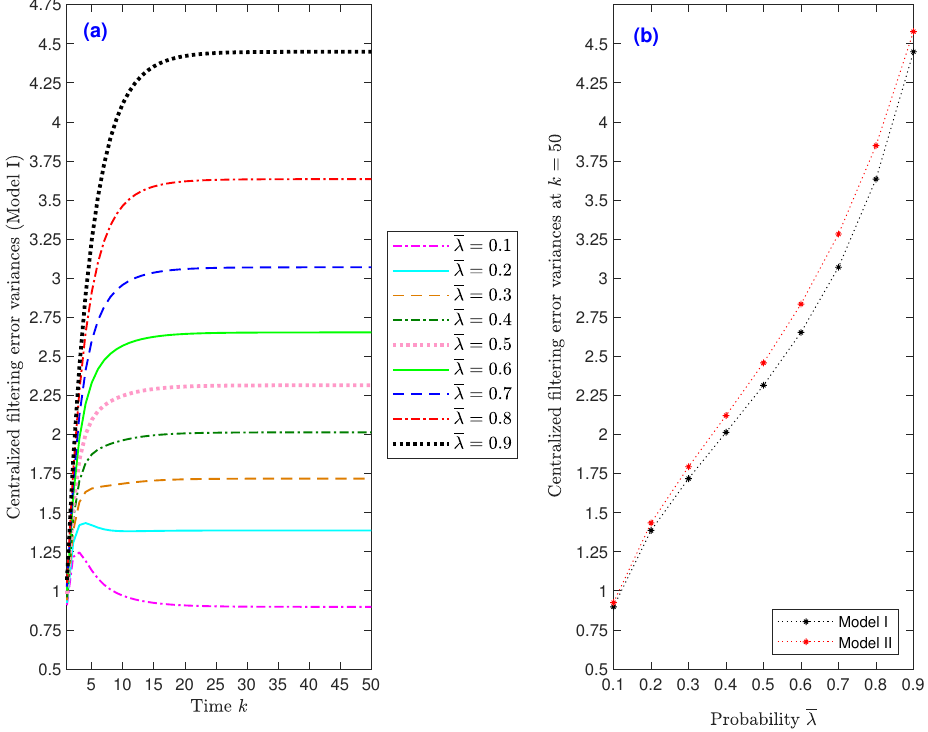
Figure 4. Centralized fusion filtering error variances: ( a ) under Model I when λ = 0.1 to 0.9; ( b ) under Model I and Model II at k = 50 versus λ